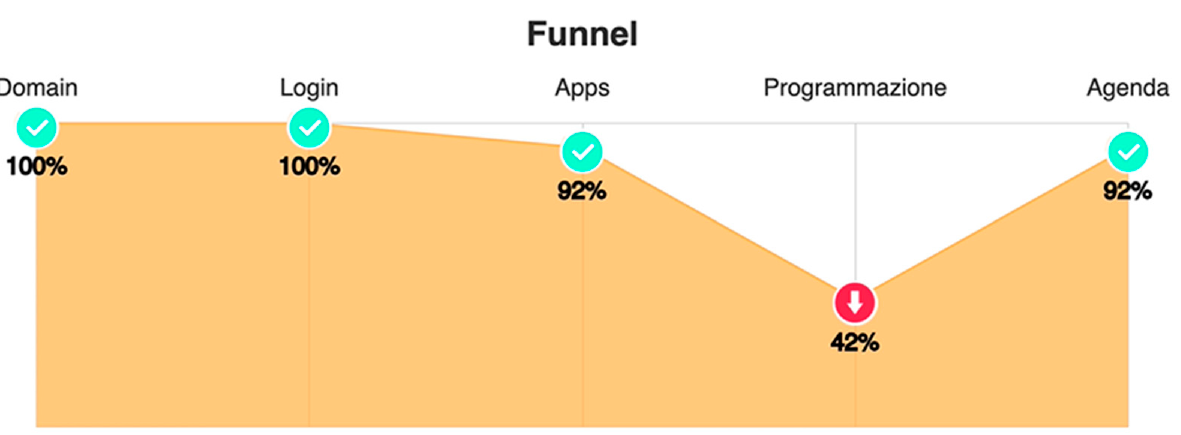
Figure 8. Funnel graph showcasing the website structure from the homepage to the “Agenda” app.